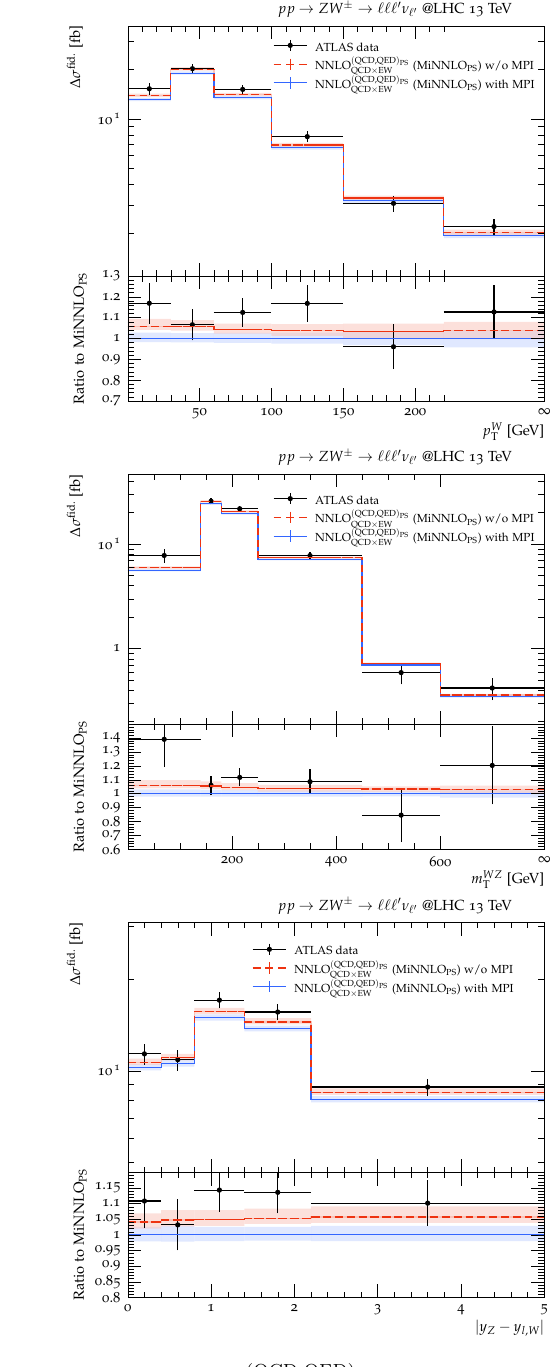
with MPI effects QCDxEW